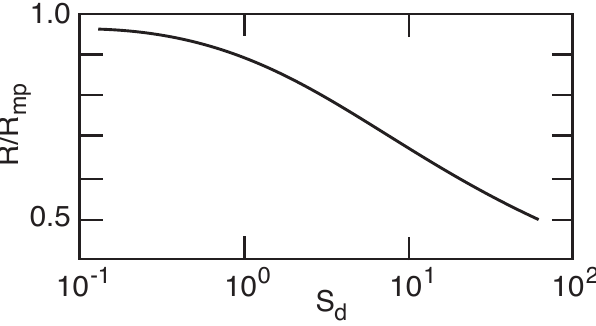
Fig. 2. The dependence of the magnetopause stagnation point dis- tance on the function S d = 1 + A d α d ( 1 + m e Q d / m p A d ) . Normalisa- tion is to the nominal stagnation point radius R mp .